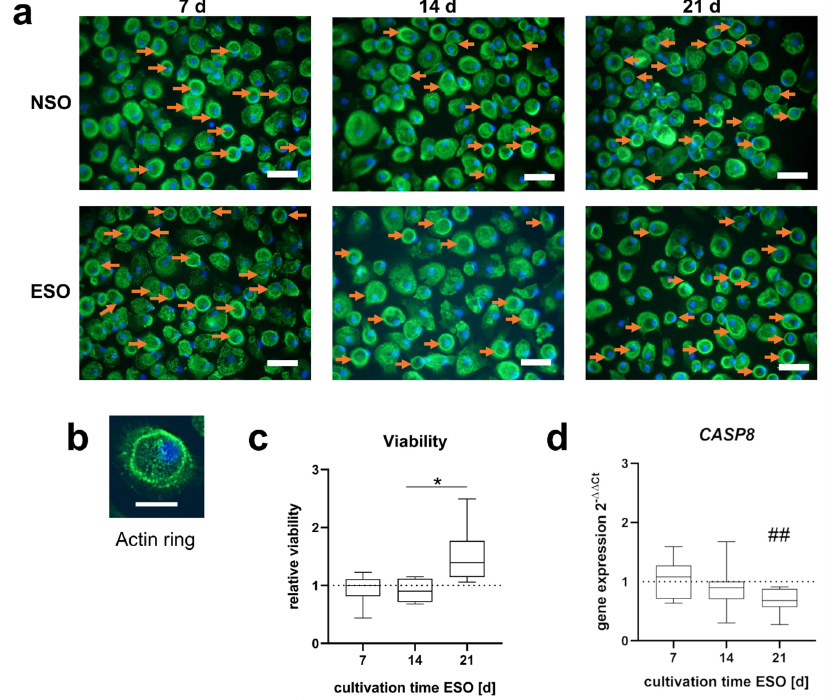
Figure 5. Morphology and viability of pre-osteoclasts after 48 h incubation with pooled supernatant of osteoblast stimulated over 7, 14, and 21 d (ESO) and without electric stimulation (NSO). ( a ) The morphology of PBMCs shows mostly round cell shapes. The actin skeleton is visualized in a green color and the nucleus in blue. Cells with an actin ring structure are highlighted with an orange arrow. The scale bar measures 50 μ m. ( b ) Pre-osteoclast with an actin ring. The scale bar measures 20 μ m. ( c ) The viability of pre-osteoclasts related to the viability of the control. Significant differences were determined using the two-way ANOVA with Tukey, * indicates significant differences between stimulation time points: * p <0.05 [n = 8]. ( d ) CASP8 gene expression data with ESO related to NSO PBMCs using the 2 −∆∆ Ct method. Significant differences were determined using the two-way ANOVA with Tukey, # indicates significant differences between the stimulated and control groups: ## p < 0.01 [n = 8].